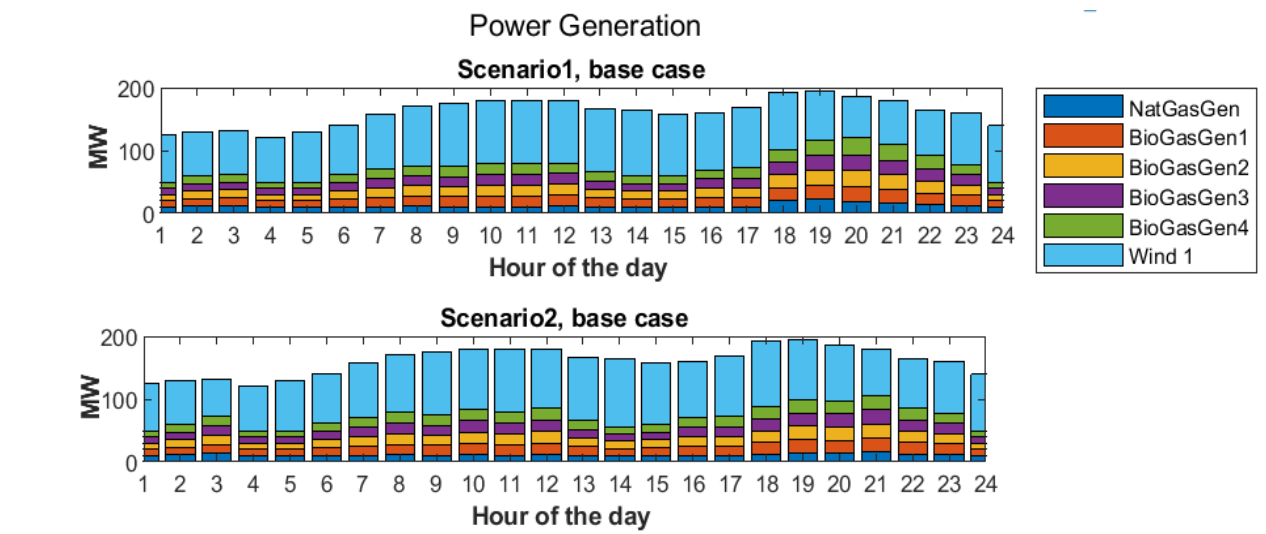
Figure 12. Power generation for scenario 1 and scenario 2: two base scenarios created using the transition matrices.